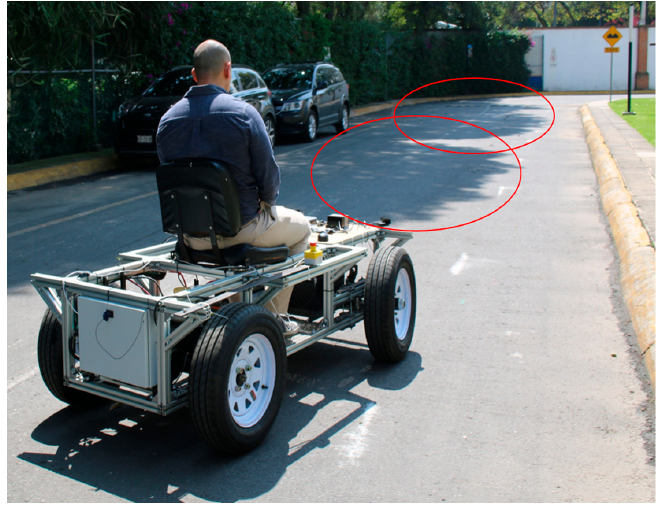
Figure 16. Examples of shadows on the day of the final presentation.